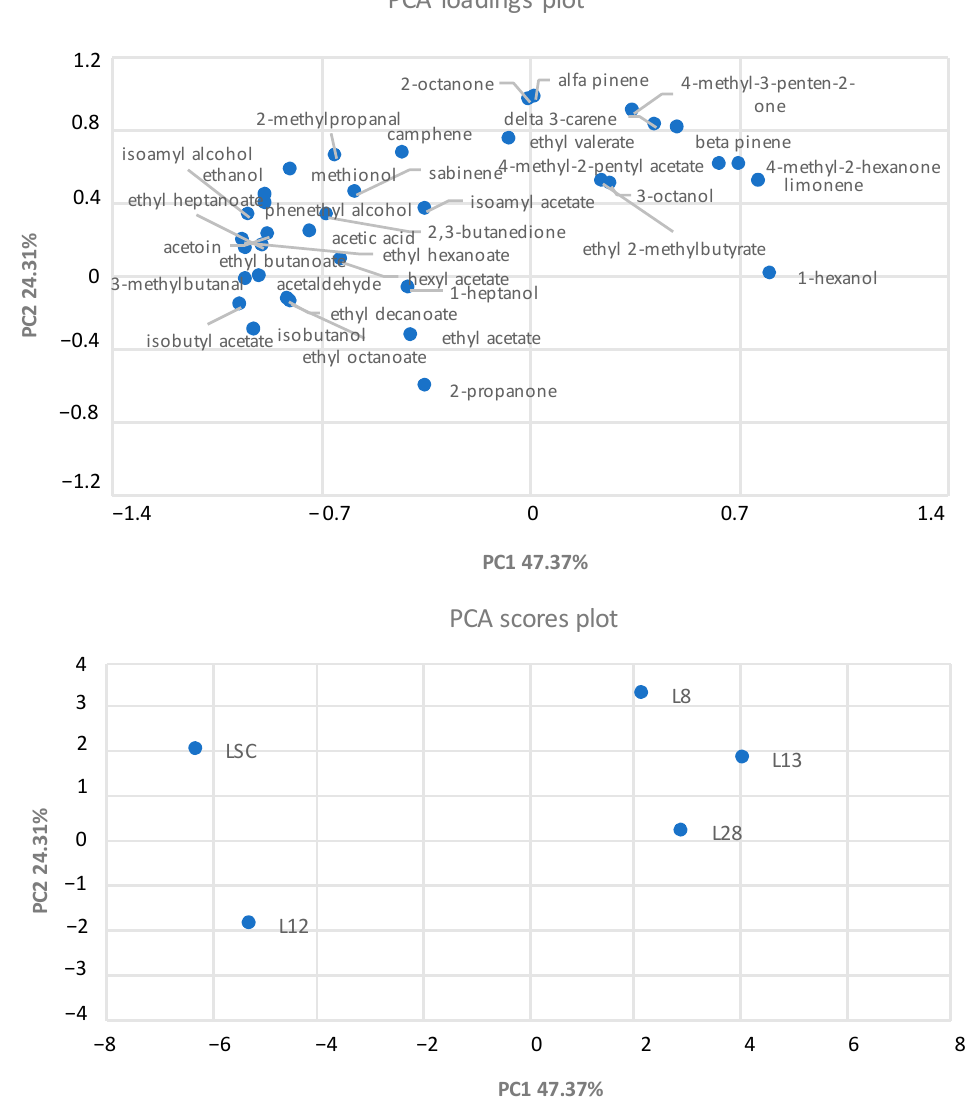
Figure 4. Principal component analysis (PCA) of volatile organic compounds that mainly differentiated the doughs inoculated with different yeasts strains. L12: S. cerevisiae ; L8, L13, and L28: H. uvarum ; LSC: commercial yeast used as control.